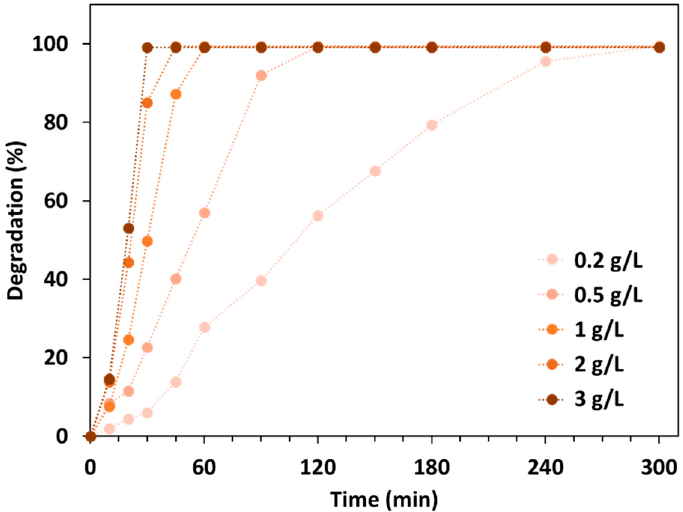
Figure 7. Degradation efficiency using different catechol-HCP-Fe doses. Reaction conditions: [H 2 O 2 ] = 0.5 M, [MB] = 100 ppm, pH = 6 (neutral pH), room temperature (27 °C).